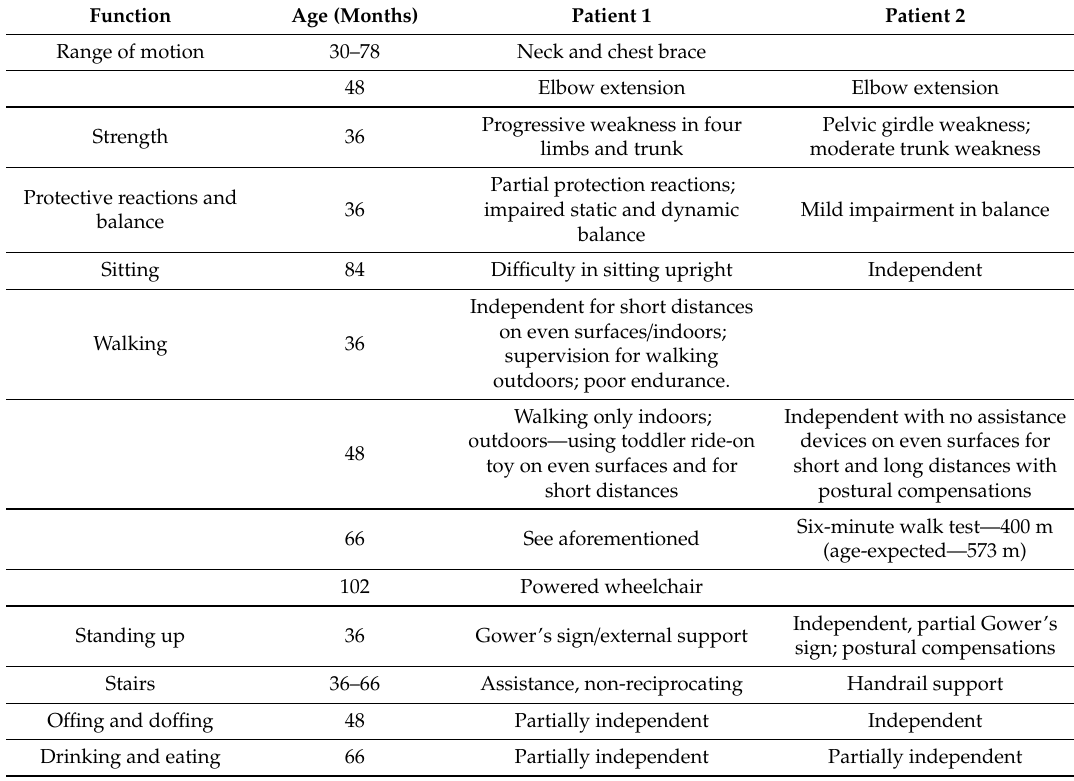
Table 2. Summary of patients 1 and 2—age of initiation of limitations in physical